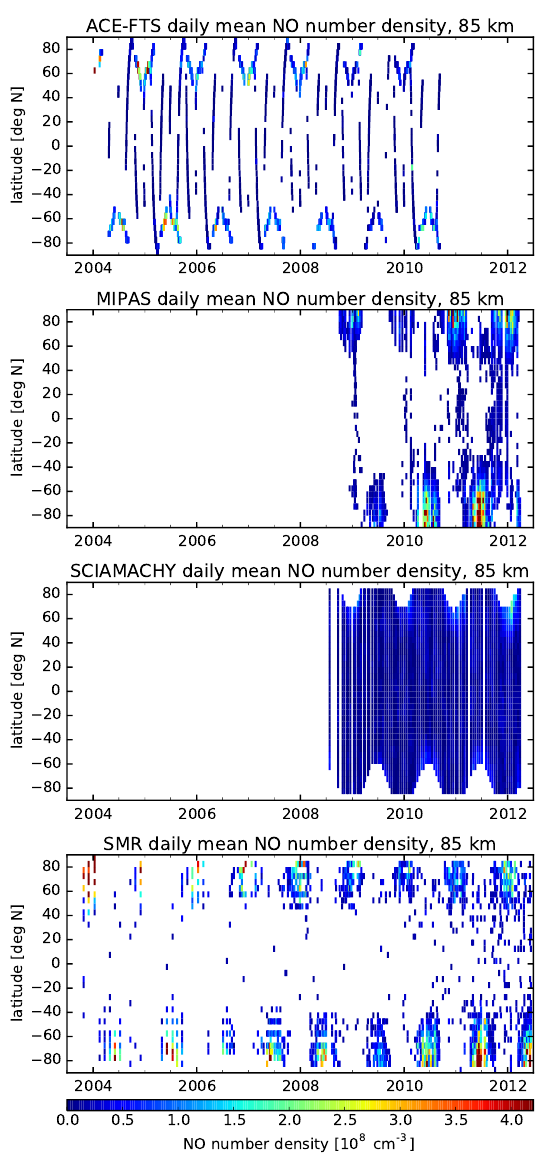
Figure 1. NO zonal mean time series at 85km from ACE-FTS, MI- PAS, SCIAMACHY, and SMR (from top to bottom).